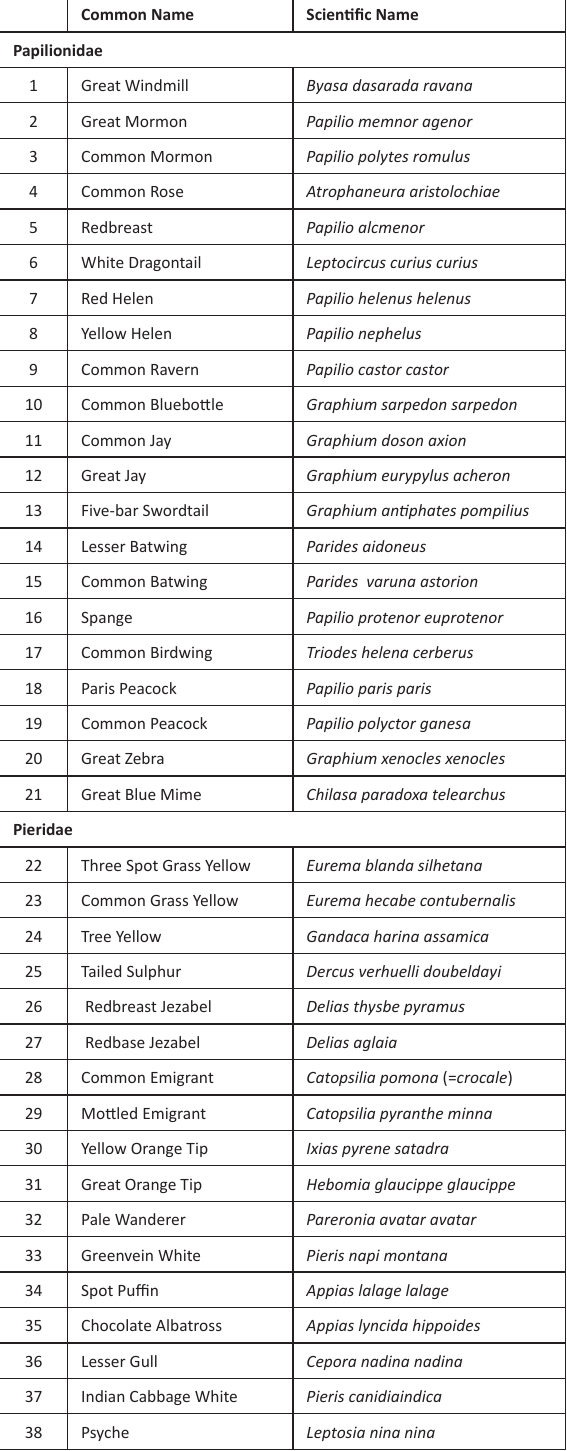
Table 1. Checklist of butterflies of Jeypore-Dehing Reserve Forest recorded by the author during February 2010–october 2011.